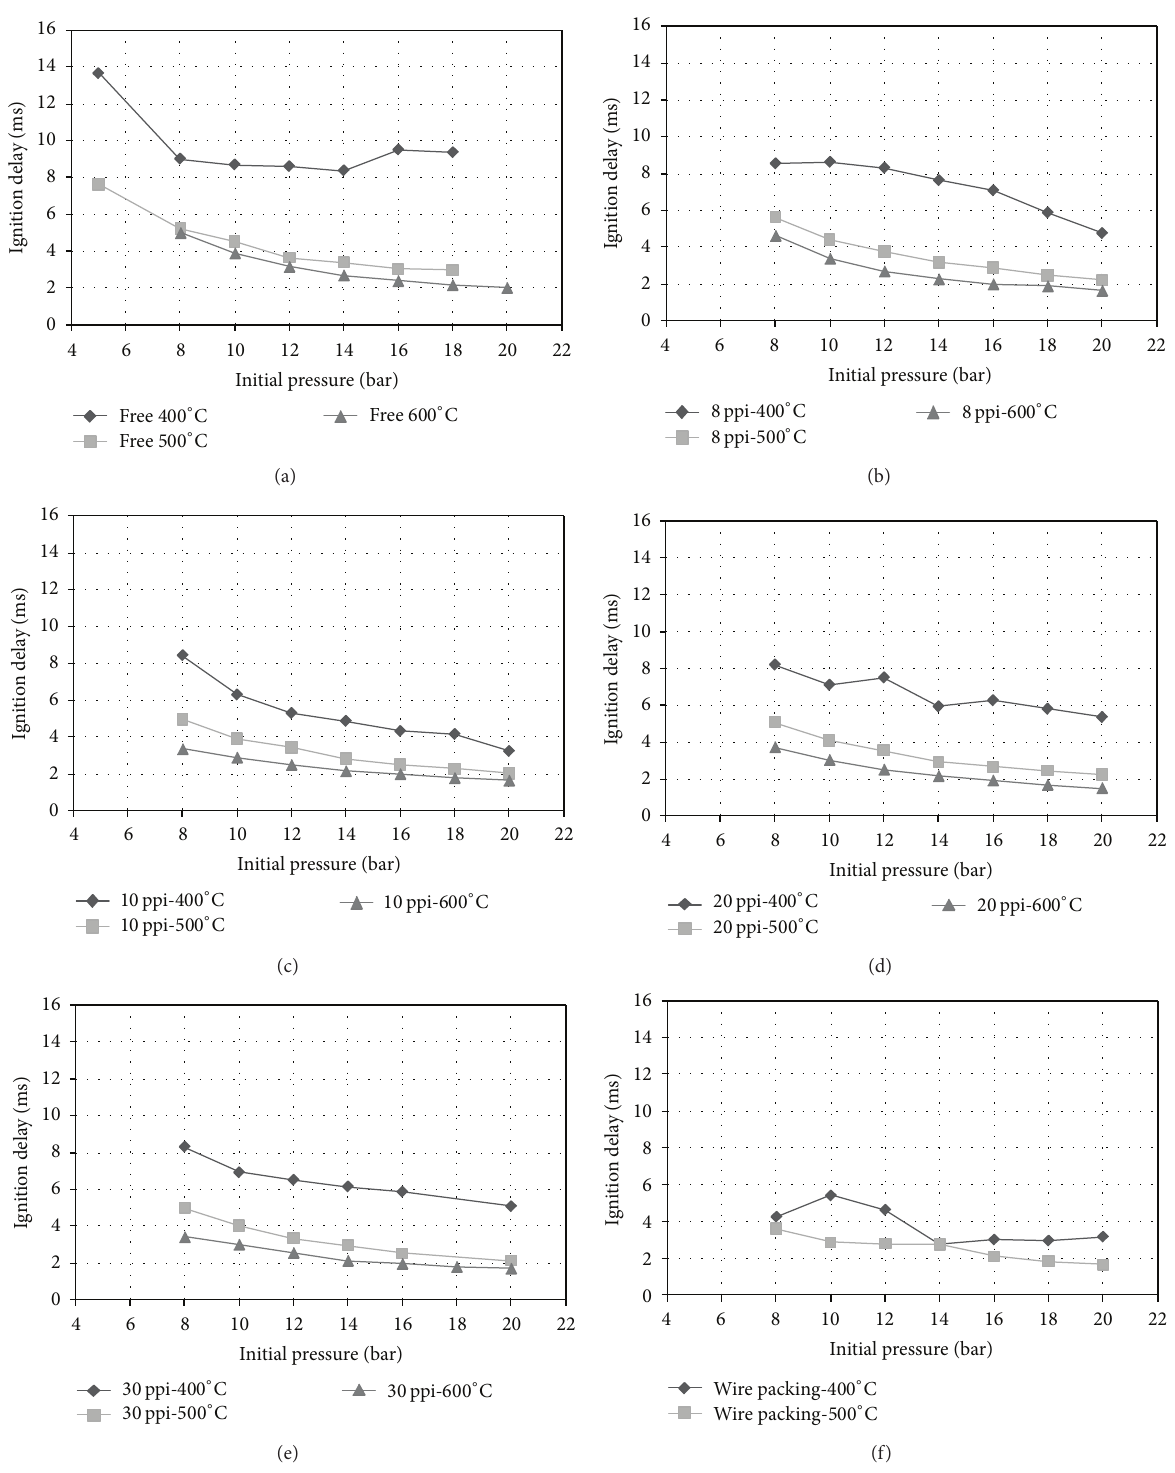
Figure 15: Comparison of delay time for heat release in free volume and in different porous reactors (SiC foam reactors and steel wire packing for three inital temperatures 400 ∘ C, 500 ∘ C, and 600 ∘ C (mass of injected fuel is 23.7 reactor) as a function of initial pressure 𝑝 IB